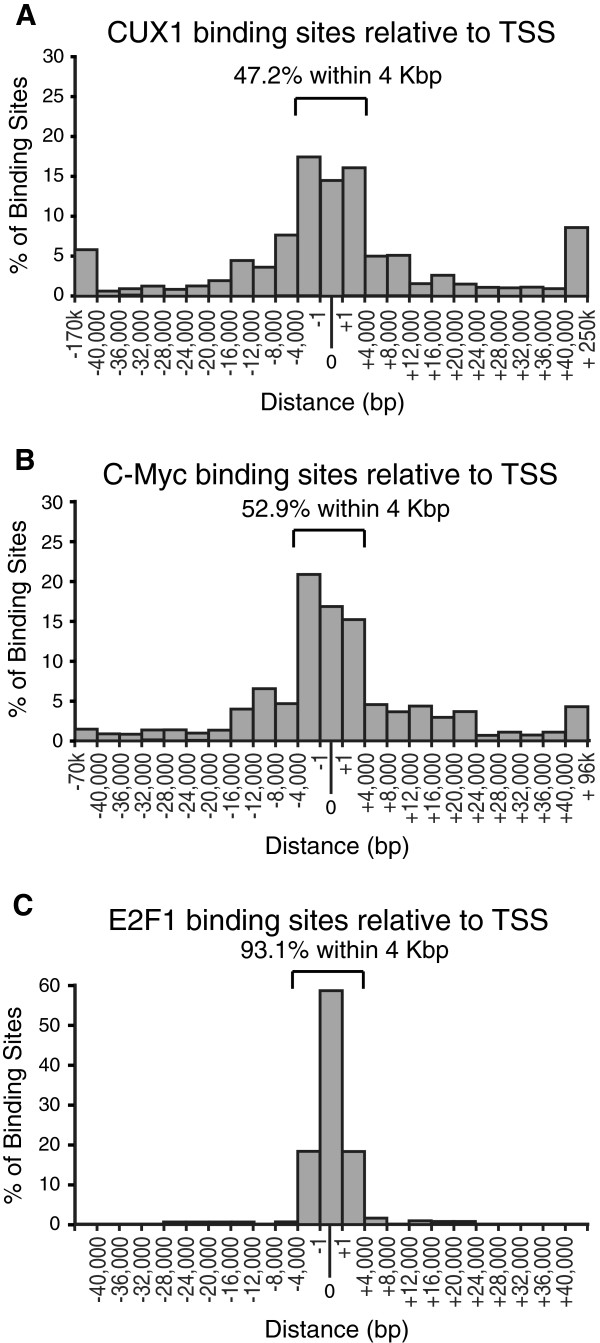
Distribution of CUX1, C-Myc and E2F1 Binding Sites Relative to
Transcription Start Sites. (A) Percentage of CUX1 binding
sites located at various distances from the closest transcription start
site. The "0" column indicates genes where the CUX1 binding site
overlaps the start site. (B) Location of C-Myc binding sites as
per A. (C) Location of E2F1 binding sites as per
A.